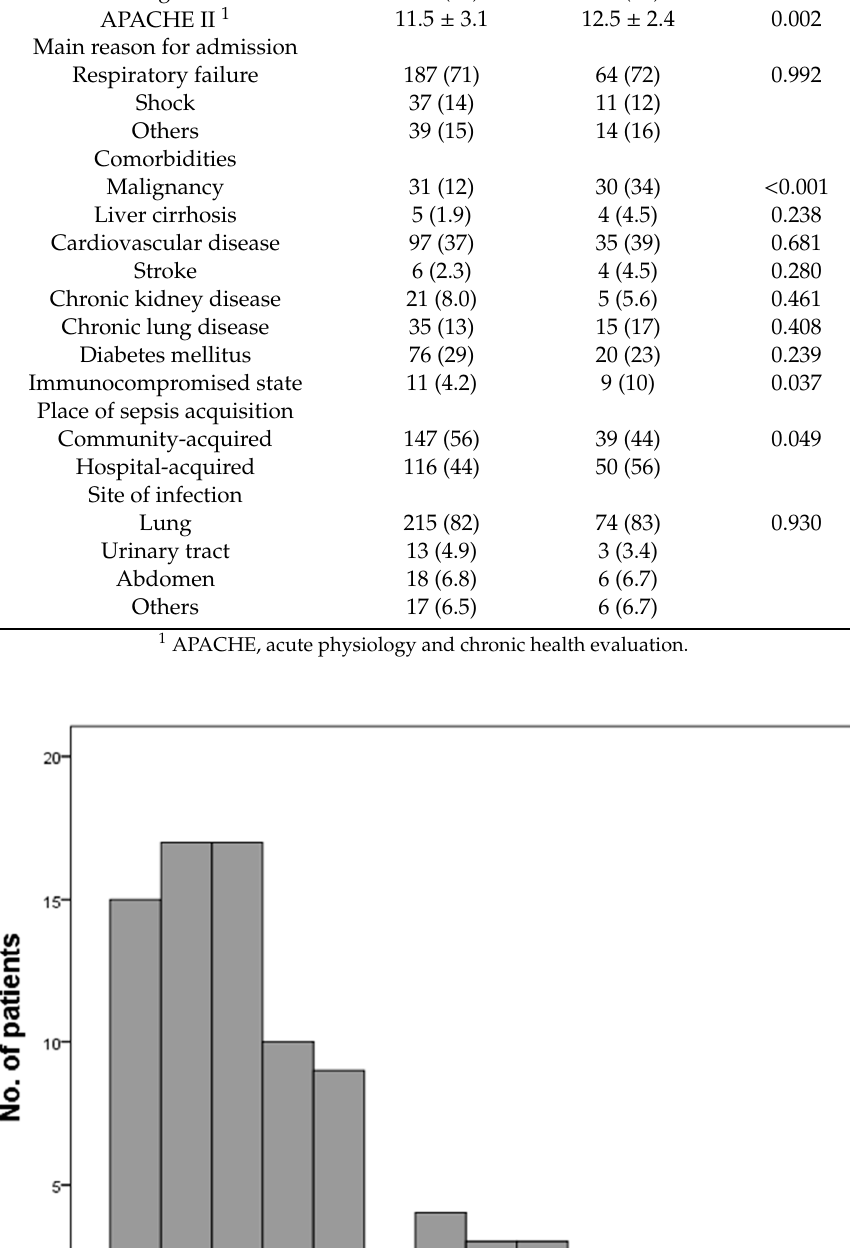
Table 2. Events during the intensive care unit stay. 134